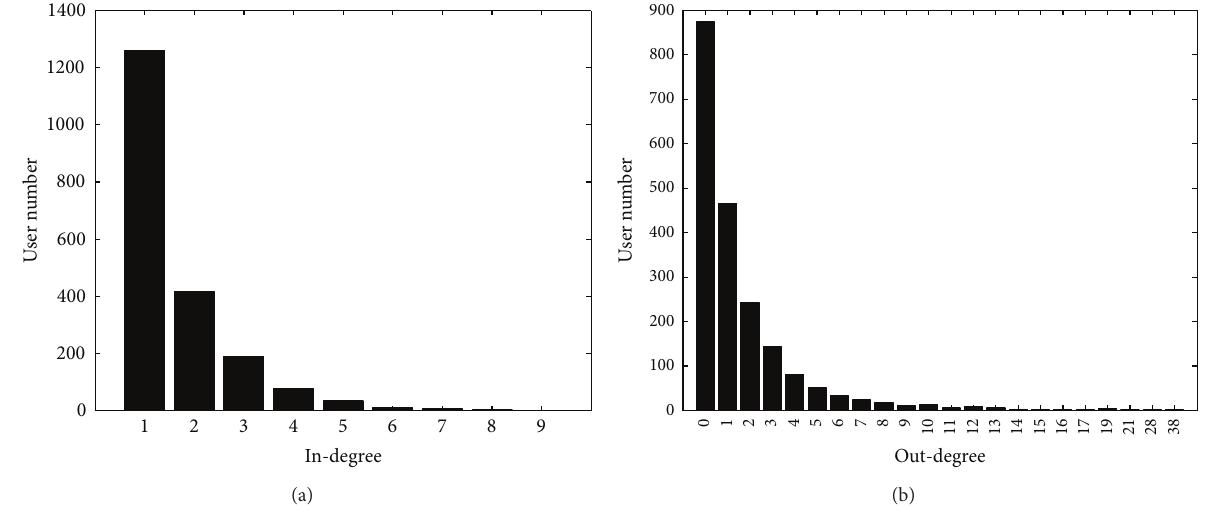
Figure 5: Distributions of (a) in-degrees and (b)